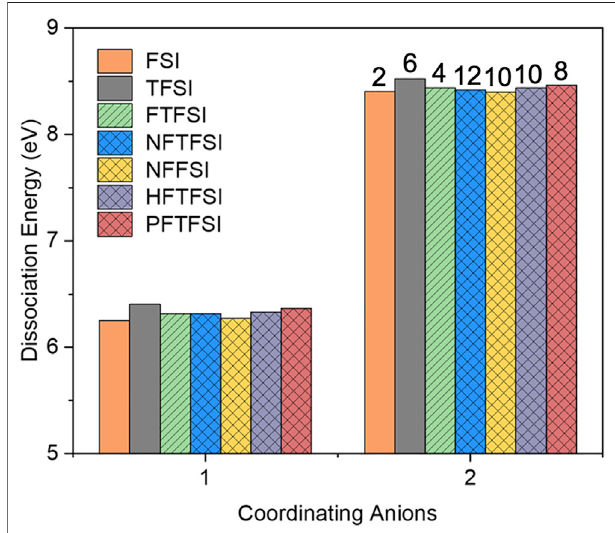
FIGURE11| Integraldissociationenergieswithrespecttothenumberof coordinatingasymmetricanions.[FTFSI]anionishighlightedwithslashes,and all other asymmetric fl uorinated anions are highlighted with crosshatches. PF, NF, and HF nomenclatures in front of TFSI or FSI stand for C 2 F 5 , C 3 F 7 , and C 4 F 9 chains, respectively. The numbers on top of the bars indicate the number of total fl uorines in the anion.